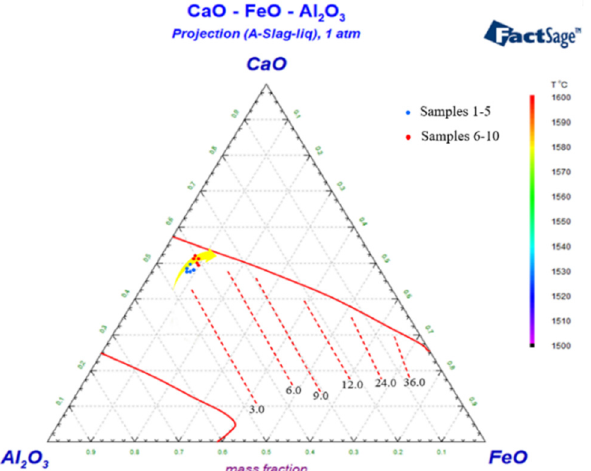
Figure 11: Equilibrium phase diagram of the Al – Ti – O system.